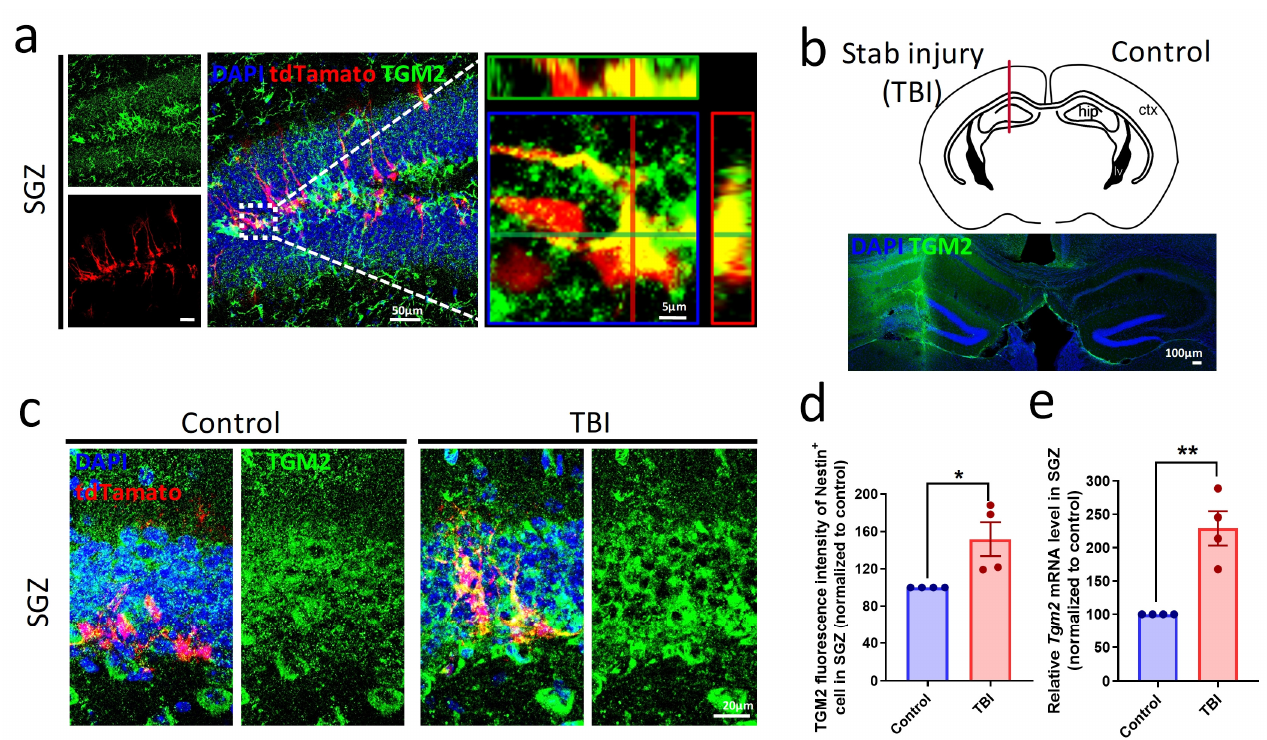
Figure 1. TGM2 is expressed in hippocampal NSPCs and upregulated after TBI. ( a ) Representative images of TGM2 immunostaining in the subgranular zone (SGZ) of Nestin-cre ER T2 ;tdTamato mice. The regions within the dotted white boxes are shown in a higher magnification 3D view (right panel). Scale bars: 50 μ m (left and middle panels), 5 μ m (right panel). ( b ) Schematic (upper panel) and representative image (lower panel) of Nestin-cre ER T2 ;tdTamato mice at 7 days post-injury (dpi). Scale bar: 100 μ m. ( c , d ) Representative images ( c ) and quantification ( d ) of TGM2 immunostaining in SGZ at 7dpi. Scale bar: 20 μ m. ( e ) Quantification of Tgm2 mRNA levels in SGZ at 7 dpi by real-time qPCR. n = 4 mice per group. Data are represented as means ± SEM; two-tailed t -test, * p < 0.05, ** p < 0.01.